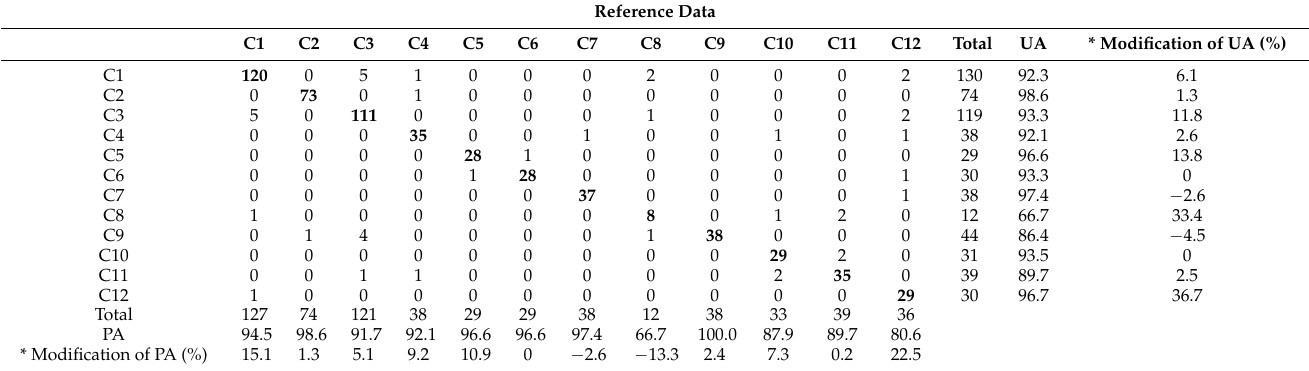
Table 6. Confusion matrix of the best performing classifier, M8, in the best scenario, NDVI+VV+VH (seventh scenario).